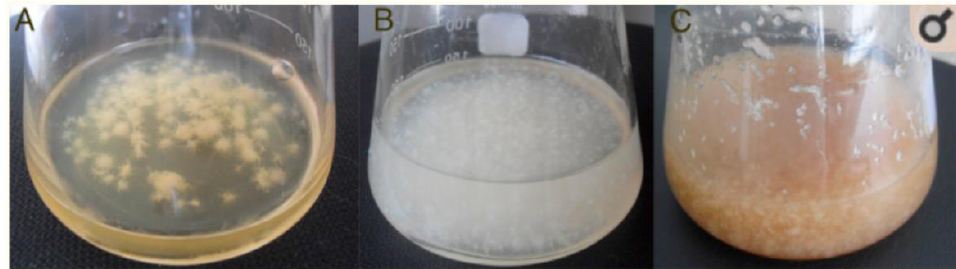
Figure 4. BC produce by Gluconoacetobacter sucrofermentas B-11267 in agitated culture conditions using HS medium ( A ), whey ( B ), and thin stillage ( C ) [6].